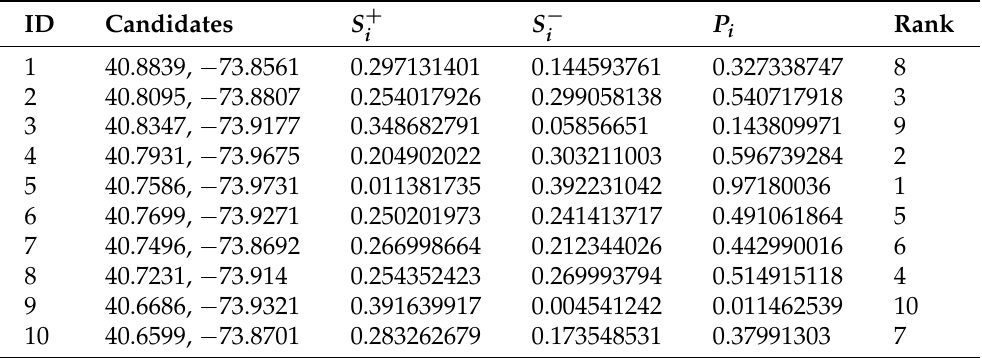
, S + , and P i values and their i i